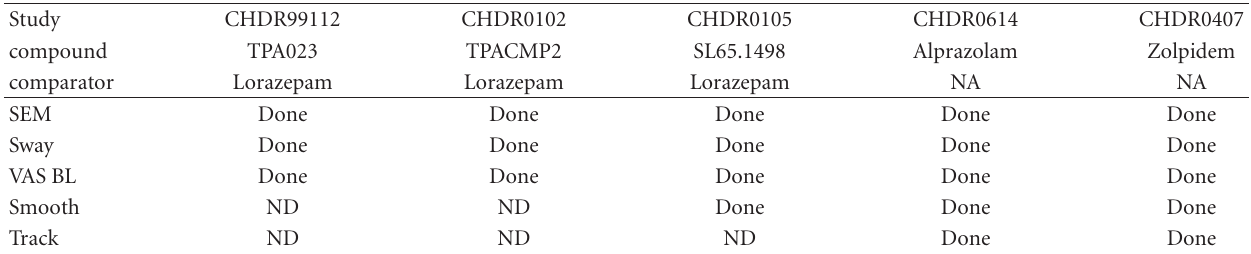
Table 3: Use of pharmacodynamic tests in each study.